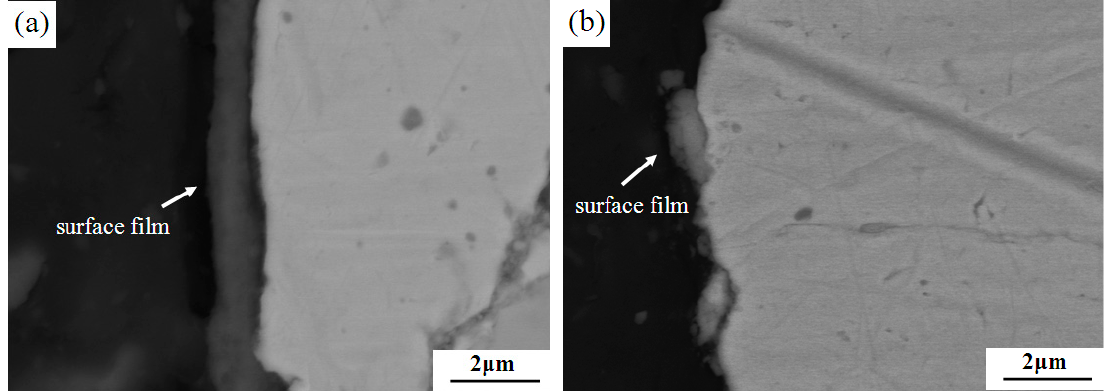
Figure 5. Morphologies of subsurface with different lubricating phase: ( a ) 5% GCB and ( b ) 5% HSG.